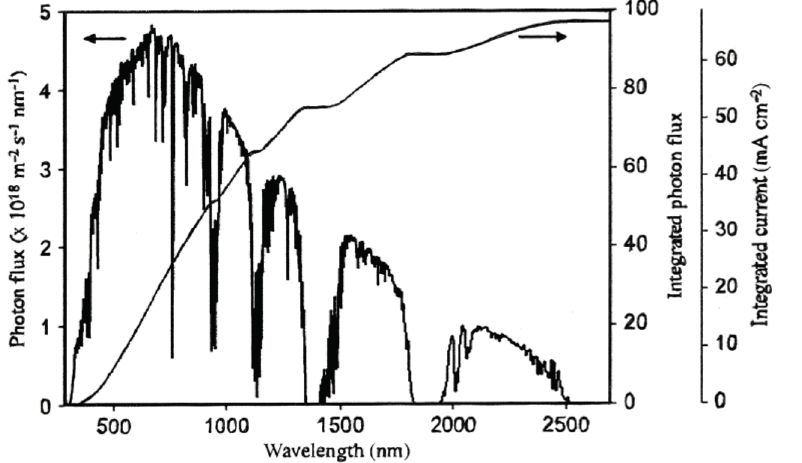
Figure 2. Solar photon flux at the earth’s surface vs. wavelength and integrated current density obtainable from an ideal PV cell (adapted from [72] with permission of Elsevier).